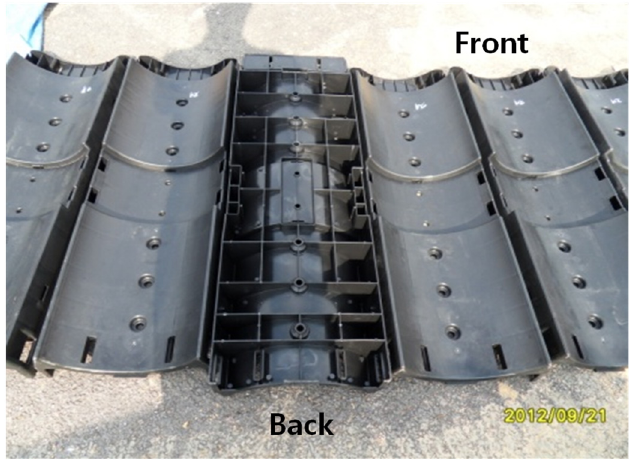
Figure 2. Plastic foundation by injection molding